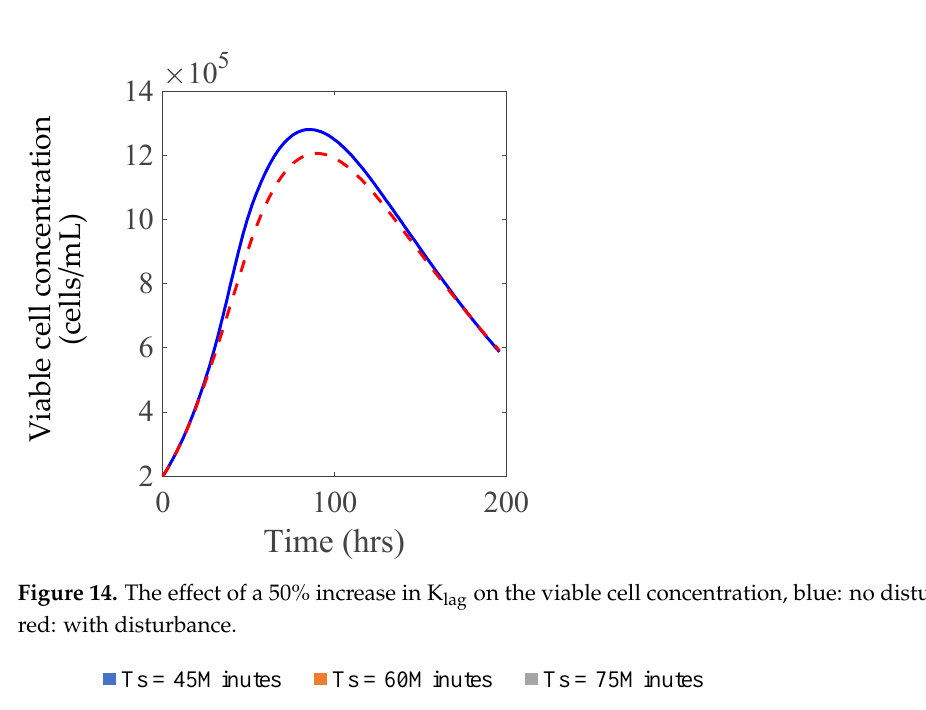
Table 7. The effect of disturbances in the feed and reaction kinetics on the IAE. (1) Setpoint 15 mM without disturbance (for reference); (2) a 20% increase in the glucose feed concentration between 100 and 150 hours; (3) a 50% increase in the lag constant (Klag). Figure 15. The effect of sampling time on the controller Figure 15. The effect of sampling time on the controller performance.